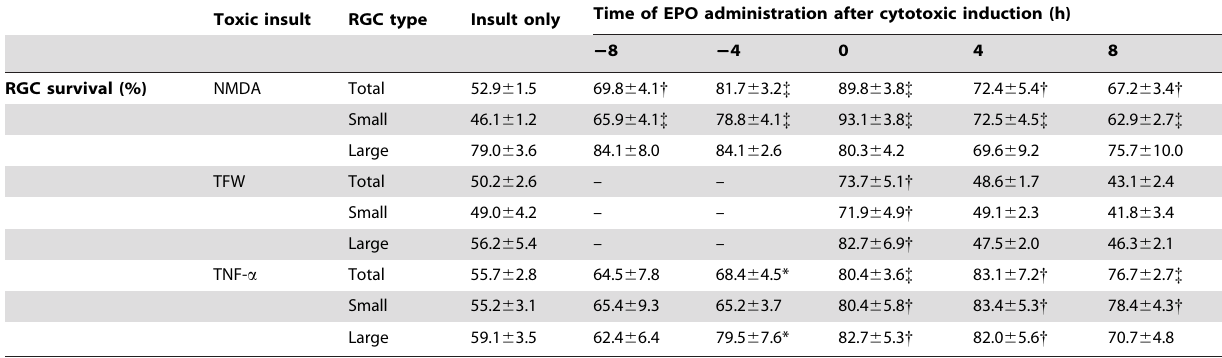
Table 1. Time course of EPO neuroprotective effects on damaged